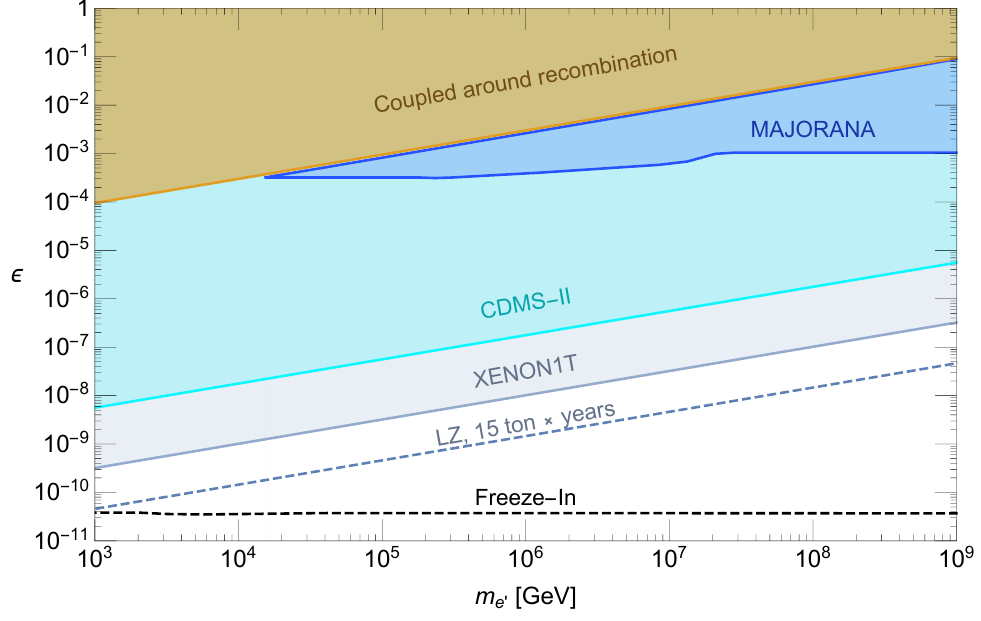
Figure 3 . Constraints on kinetic mixing if DM is composed of mirror